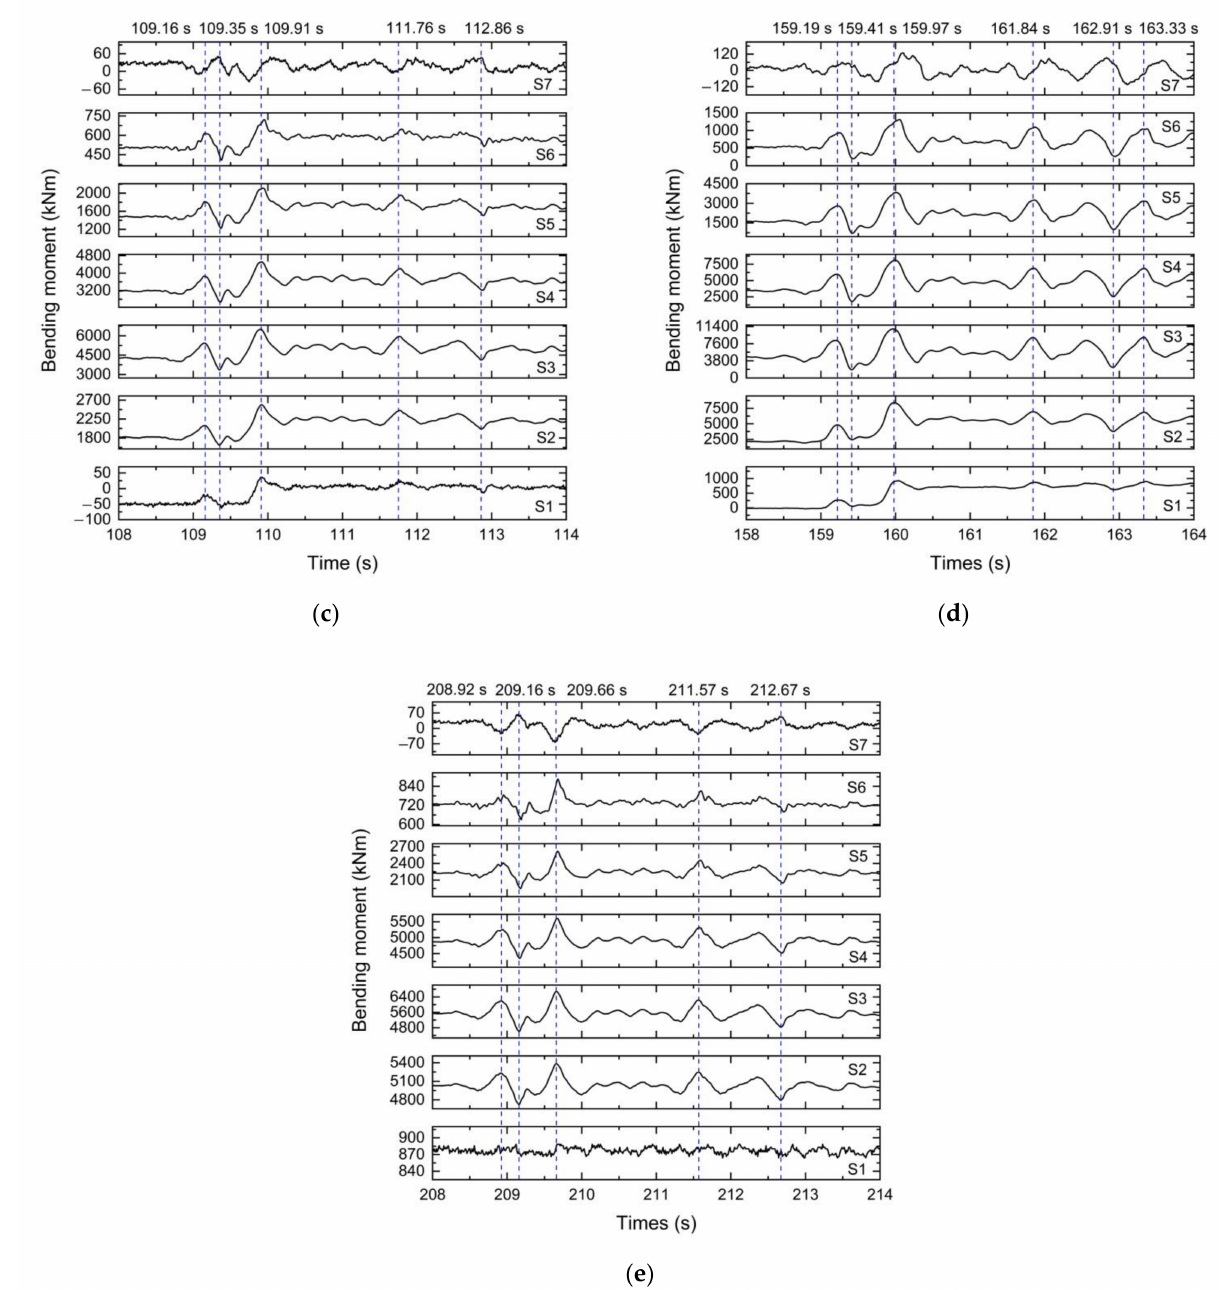
Figure 15. Time–history curves of bending moments in centrifuge tests: ( a ) EQ1; ( b ) EQ2; ( c ) EQ3; ( d ) EQ4; ( e ) EQ5. It can be seen from Figure 16 that the dynamic bending moment corresponding to each characteristic time changes within the envelopes of the maximum and minimum dynamic bending moments. Therefore, the envelopes of maximum and minimum dynamic moments can be used as a basis to determine the load in the seismic design of a stabilizing pile. When the input seismic load is relatively small (EQ1, PGA = 0.055 g; EQ2, PGA = 0.125), the positive and negative dynamic bending moments of the pile are quasi-symmetrically distributed, and the residual bending moment after the earthquake is small (and even negligible in EQ1) (Figure